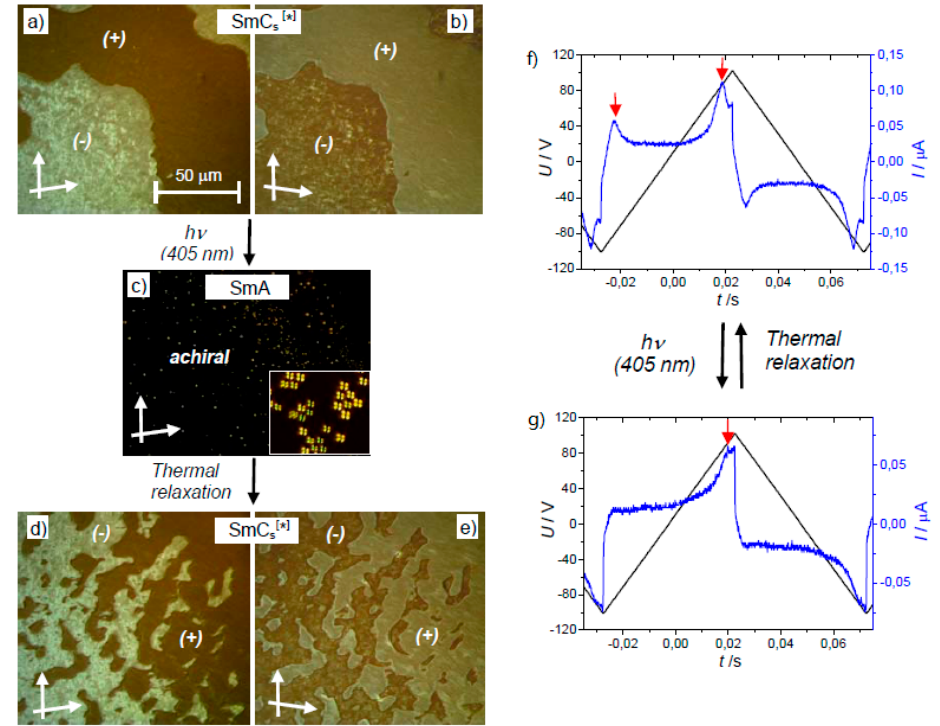
Figure 25. The optical texture of compound 16b exhibiting: ( a – e ) the isothermal photoinduced on-off-switching of chirality at T = 152 °C in a homeotropic cell. The inset indicates a magnified area of Maltese crosses as typical for defects in homotropic SmA phases; The isothermal switching of compound 18a between ( f ) antiferroelectric-like and ( g ) ferroelectric-like switching in the paraelectric SmC phase range at T = 101 °C in a 6 µm ITO cell. (Reproduced with permission from ref. [90], copyright John Wiley and Sons 2017, https://doi.org/10.1002/chem.201806180).